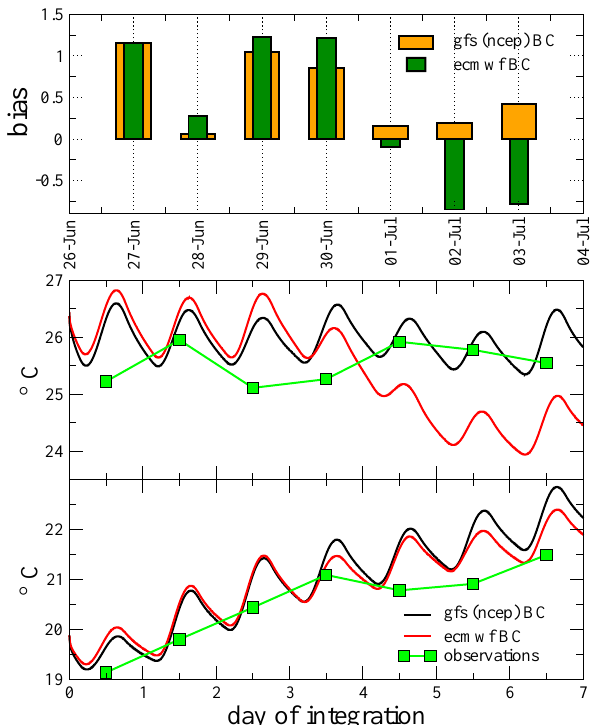
Fig. 10. The top panel shows BIAS scores for two different ini- tial and boundary conditions. NCEP data are shown in orange, ECMWF data are shown in green. The period of integration was 26 June–4 July, 2006. The middle panel shows time series of area- averaged SST over the whole Adriatic from both forecasts for the same period as in the previous figure; ECMWF is shown in red, NCEP in black, and observations in green. The bottom panel shows a time series of area-averaged SST for the forecast starting on 13 June 2006. Note that here the two forecasts are very close and both are close to the observed SST.